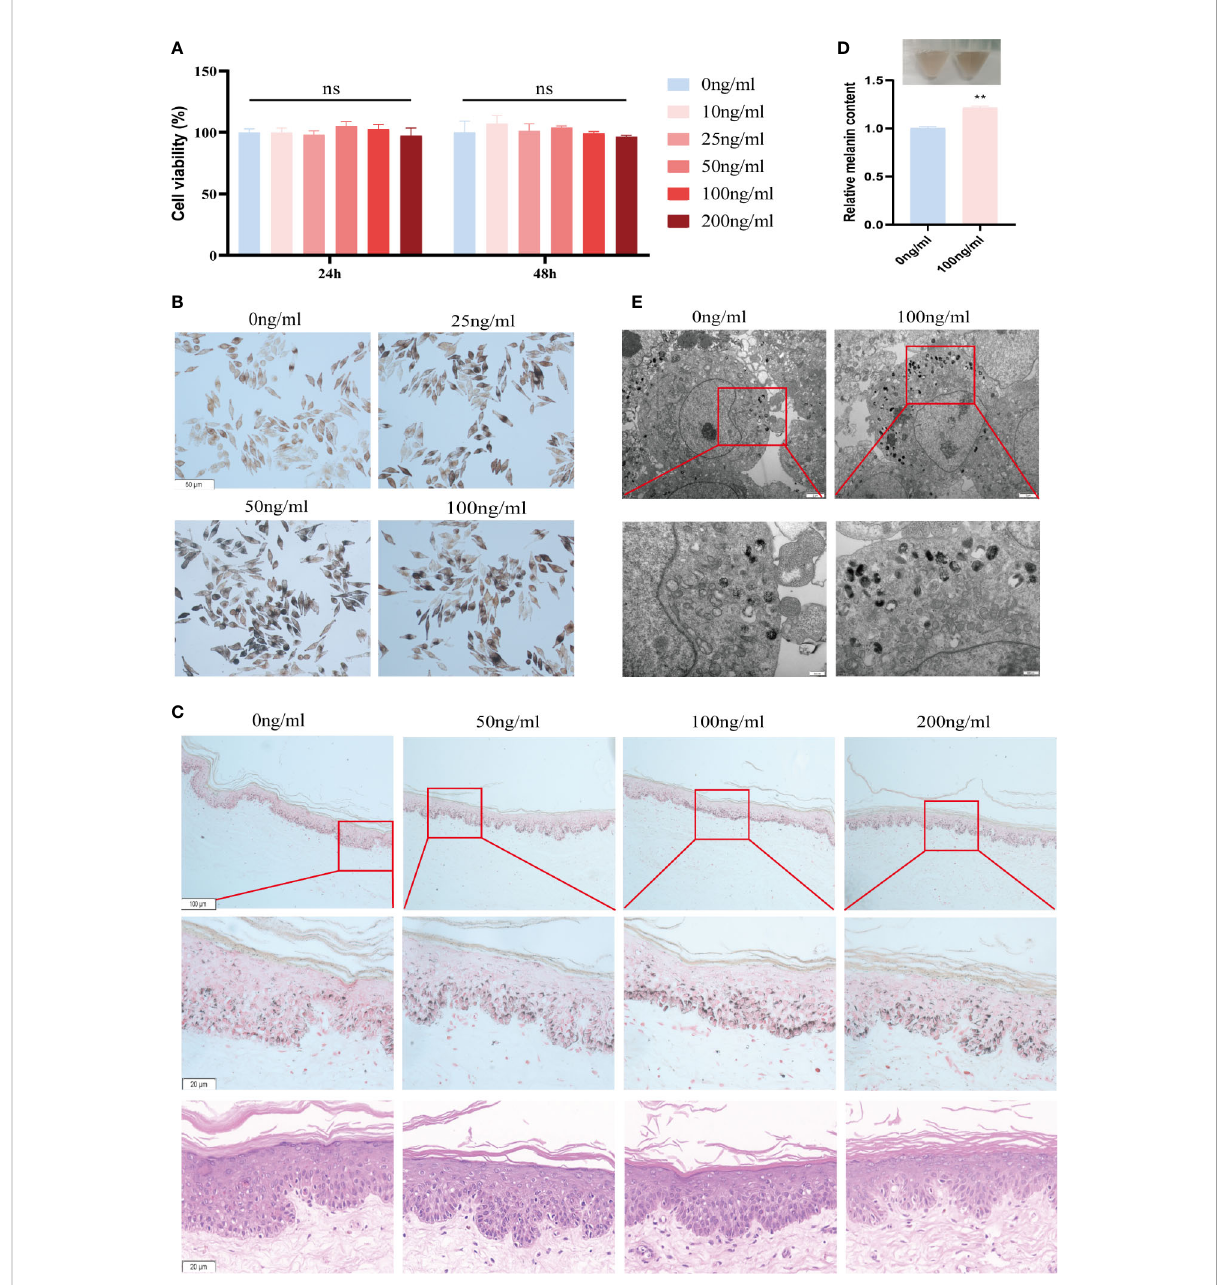
FIGURE 5 IL-37 increases melanin content in MNT1 cells and human foreskin. (A) Viability of MNT1 cells. (B, C) Representative images of Fontana-Masson- stained MNT1 cells (B) and human foreskin (C) showing melanin granules. (D) Melanin content was measured by NaOH method. (E) Melanosomes was observed by TEM. **P < 0.01. ns, No signi fi cant